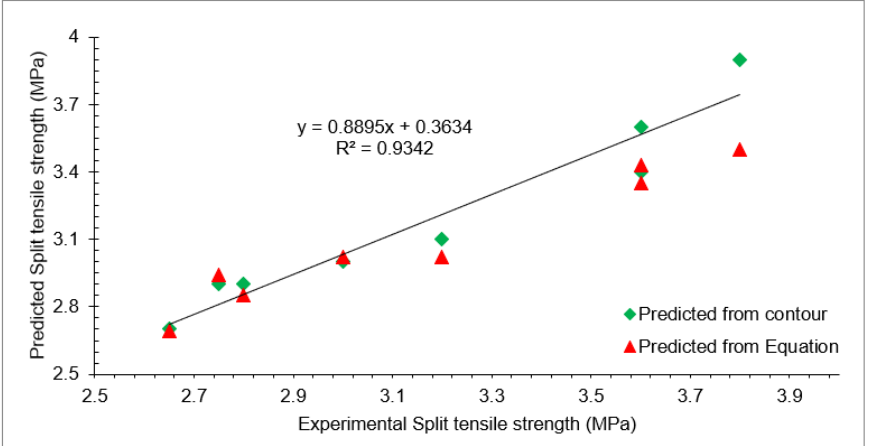
Figure 14. Correlation between experimental and predicted split tensile strength.